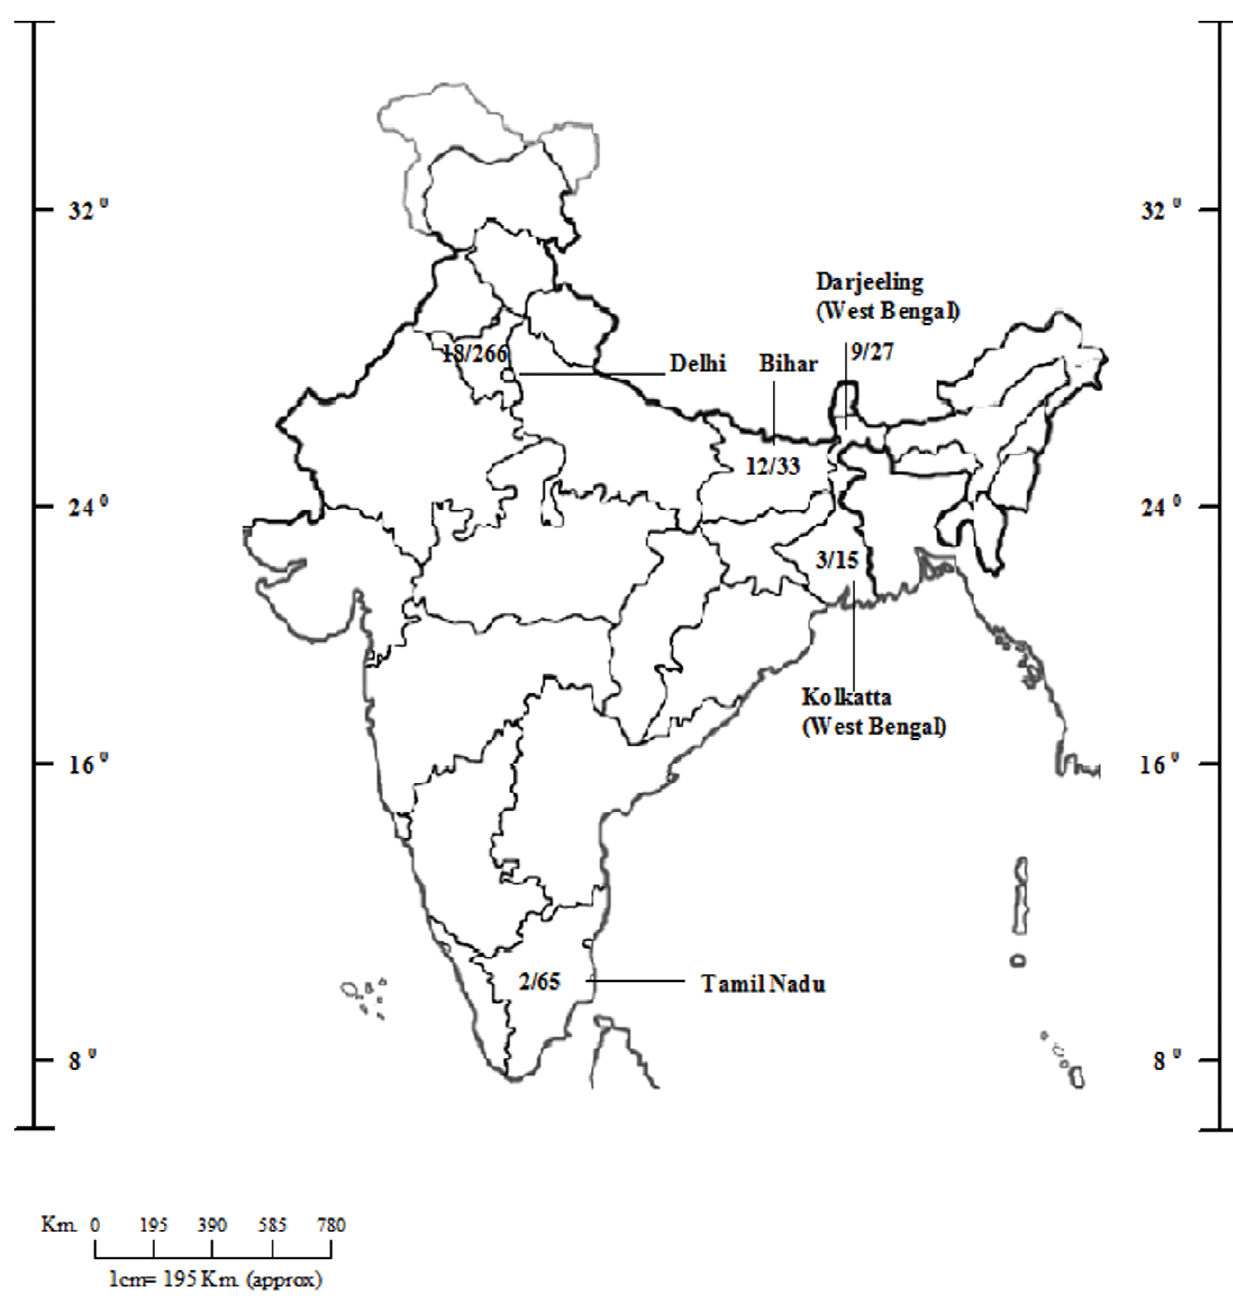
Figure 1. An outline map of India showing state-wise isolation of multiple-triazole resistant Aspergillusfumigatus isolates from variety of environmental samples.